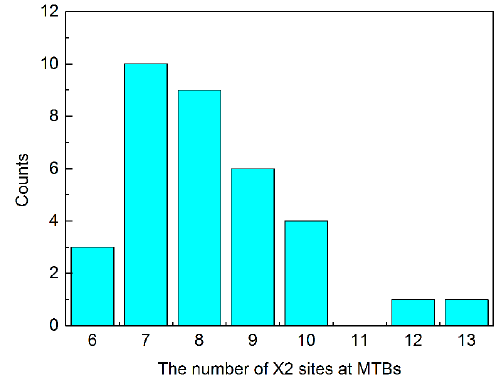
Figure 4. The histogram of the number of X 2 (S 2 , S+Te, or Te 2 ) sites inside the MTBs. The derived mean value is 8.2, which is very close to the expected value of 8.